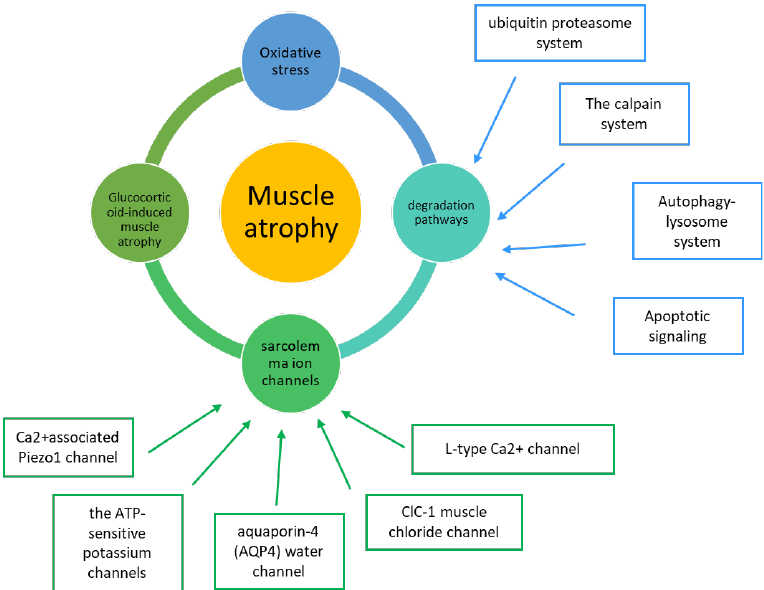
Figure 3. Summary of the principal mechanisms leading to muscle atrophy. Focus on degradation pathway and ion channel involvement.